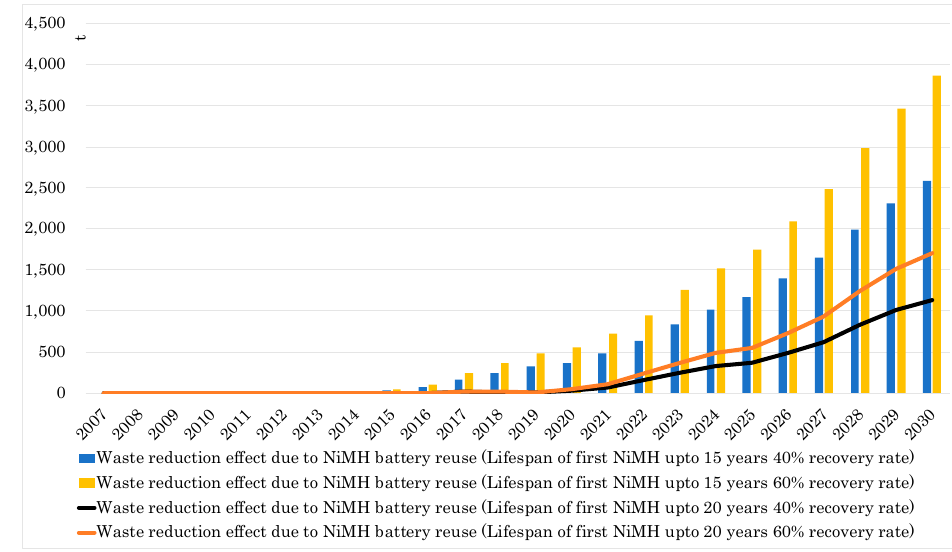
Figure 12. Waste reduction effect due to the reuse of waste NiMH battery. Source: Figure made by the